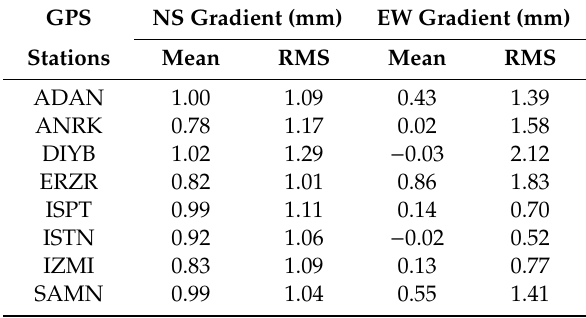
Table 2. Mean and RMS values of the NS and EW gradients di ff erences on days 168–180 in 2011.